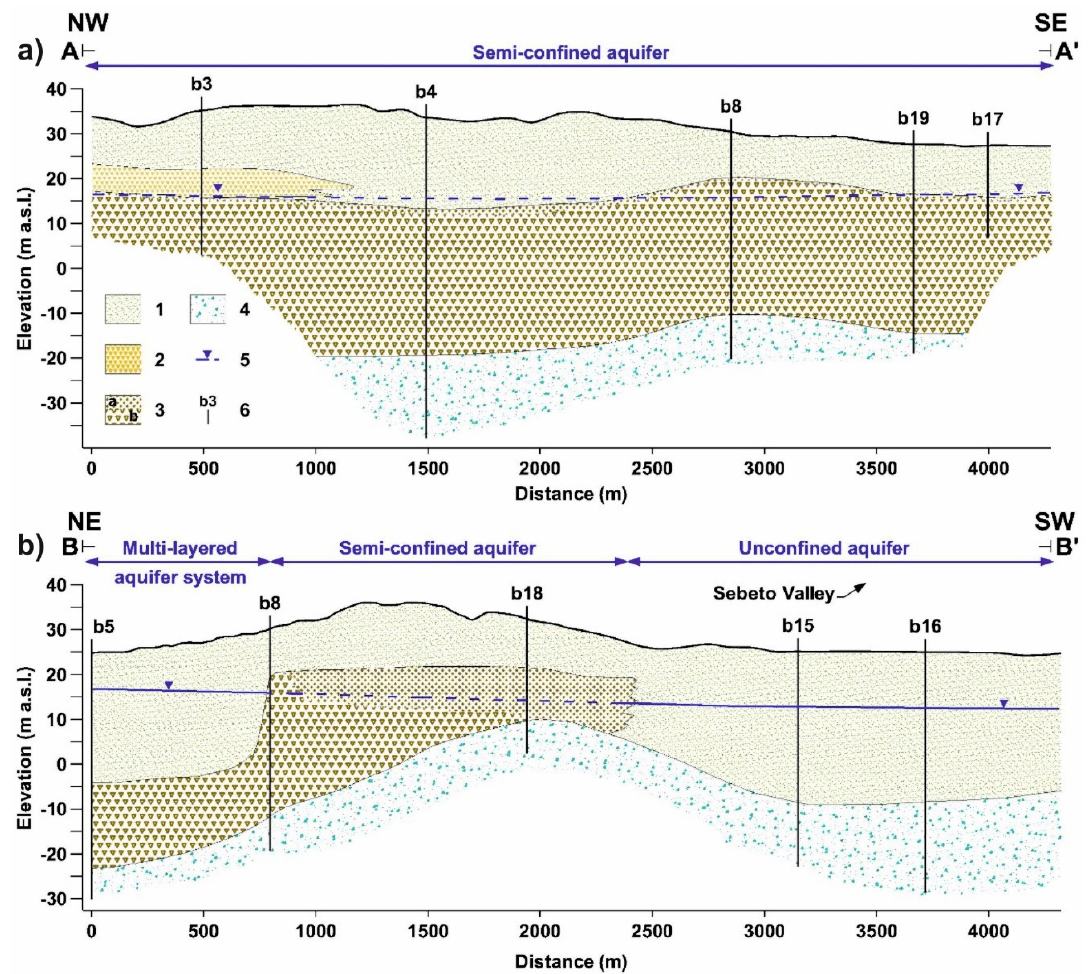
Figure 2. 2D hydrostratigraphic model of the aquifer system. Legend: 1) shallow pyroclastic-alluvial- lacustrine complex; 2) Neapolitan Yellow Tuff (NYT); 3) Campanian Ignimbrite (CI) in incoherent ( a ) or lithoid ( b ) facies; 4) deep pyroclastic sandy complex; 5) phreatic ( a ) and semi-confined ( b ) piezometric level; 6) borehole. See Figure 1b for the location of section traces and boreholes.